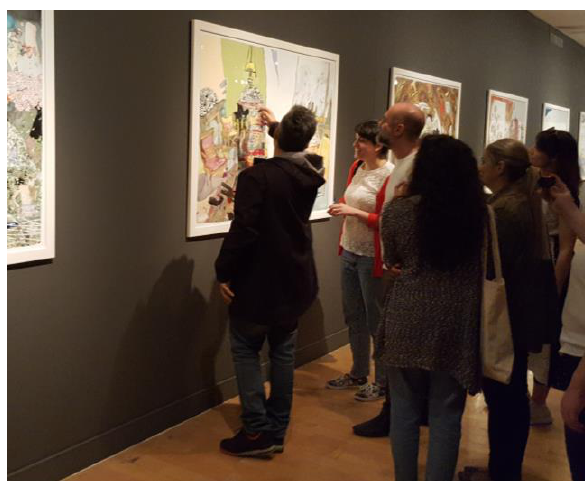
Figure 4. Snapshot from playtesting with the artist: one participant reveals his personal thoughts, pointing to particular elements of the artwork.